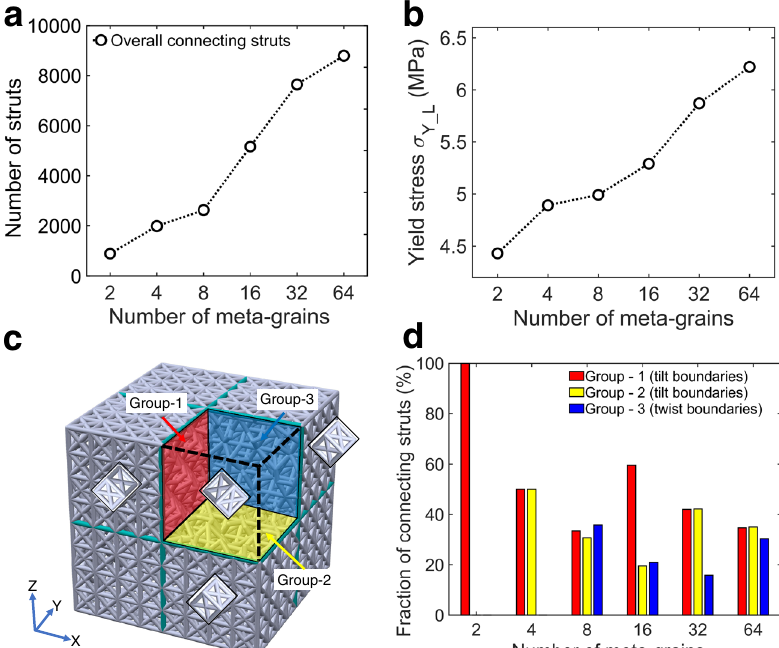
Fig. 6 Correlating the hardening effects to the boundary coherency and types. a The total number of struts connecting to the meta-grain boundaries. b Measured yield stress for meta-crystals containing different numbers of meta-grains. c Schematic diagram illustrating the classi fi cation of boundaries with insets showing lattice orientation in each grain. d The fraction of struts connected to boundaries of a speci fi c boundary